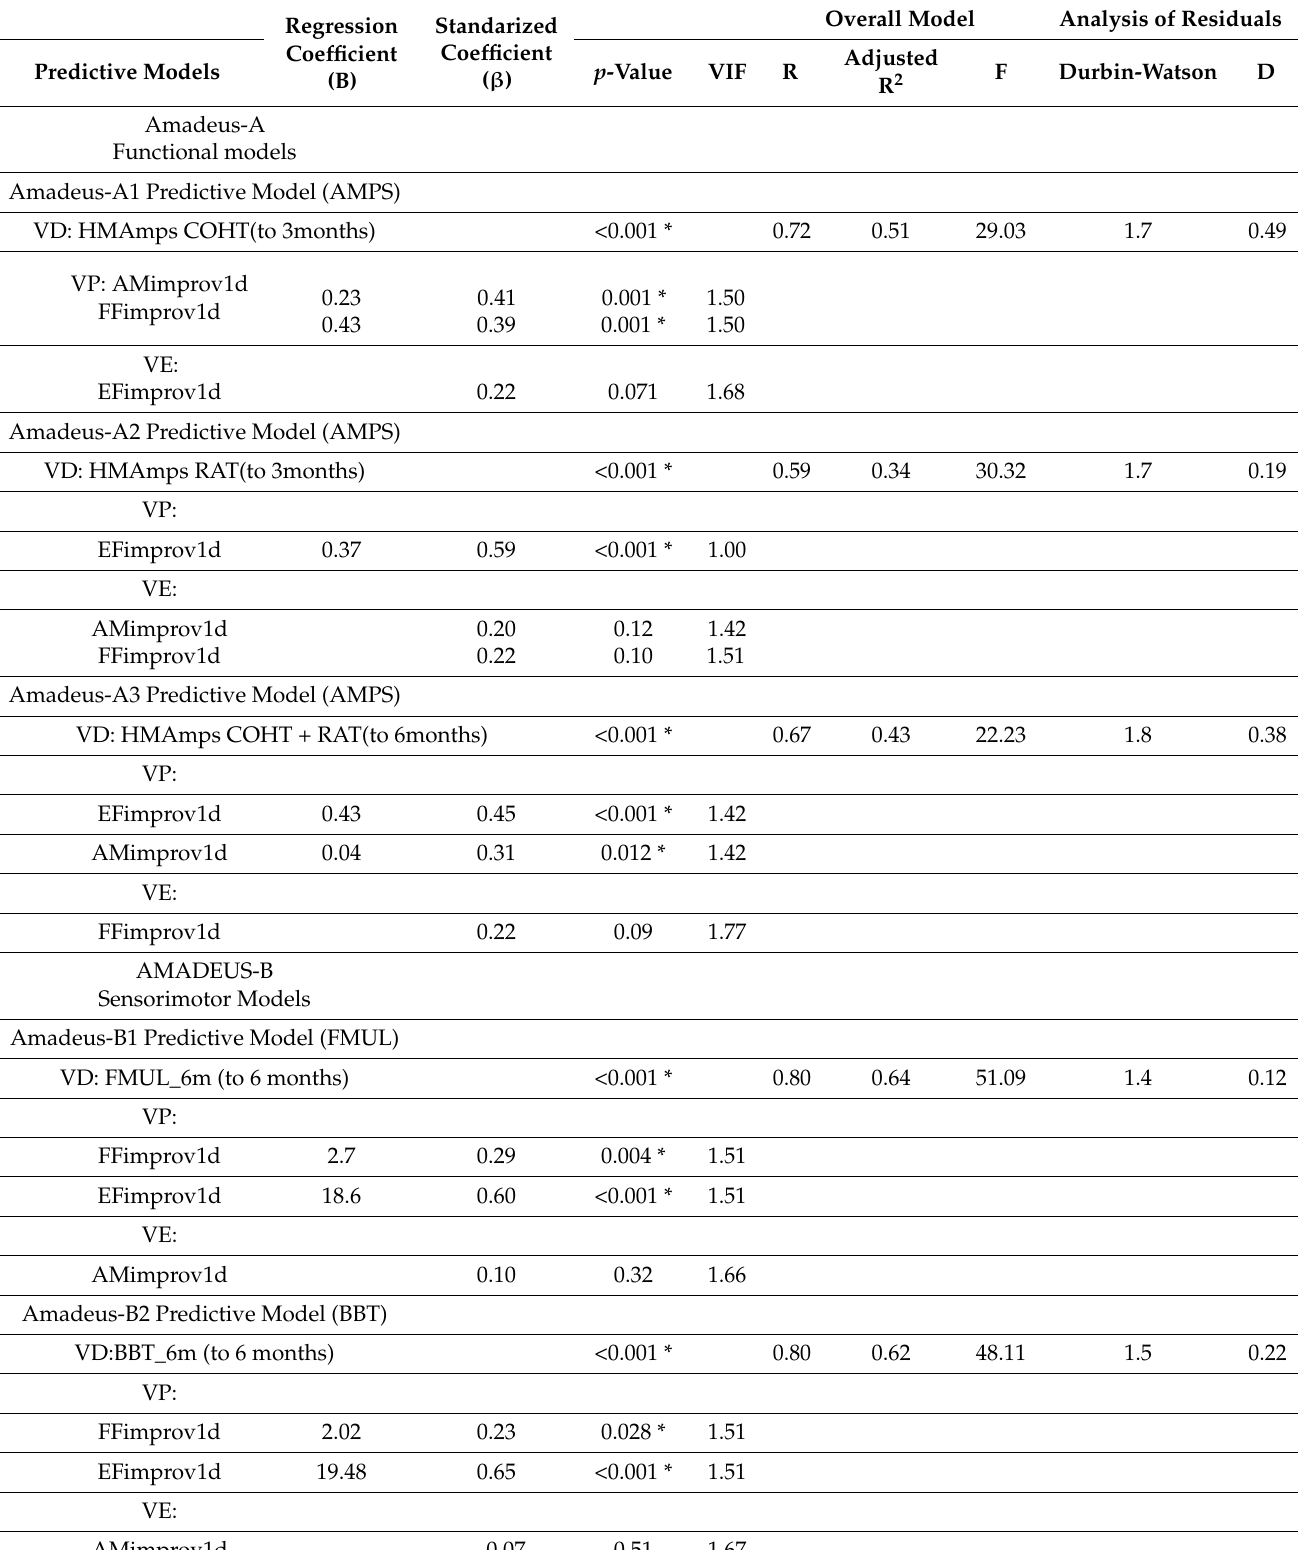
Table 5. Backward stepwise multiple linear regression analysis for the predictive models Amadeus-A and Amadeus-B at3 and 6 months post-intervention based on the evaluation of the effect of the first pre-intervention